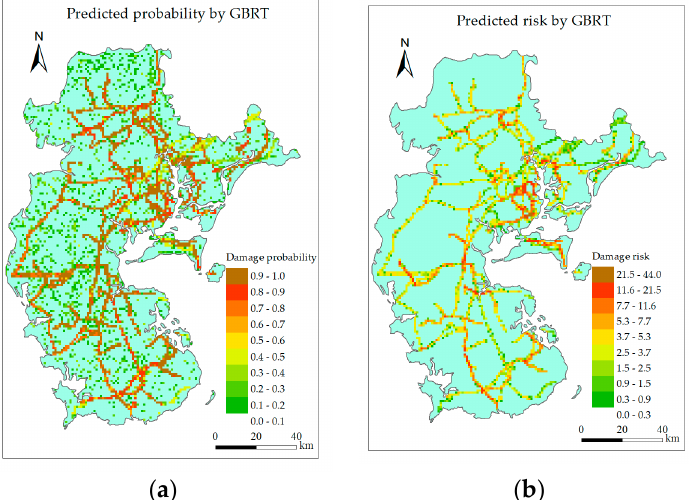
Figure 11. Prediction results of GBRT. ( a ) Predicted damage probability. ( b ) Predicted damage risk.